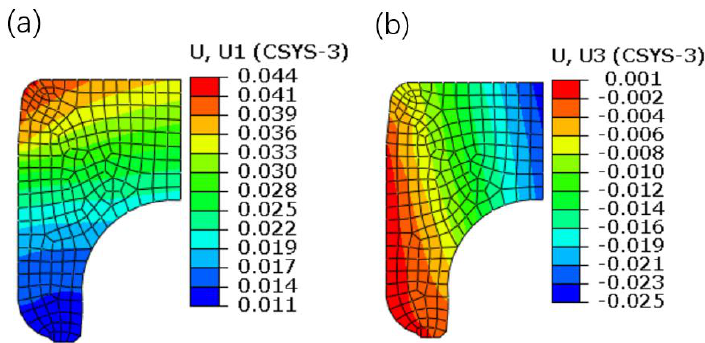
Figure 21. Displacement contour plots of the inner ring. ( a ) Radial displacement. ( b ) Axial displacement.